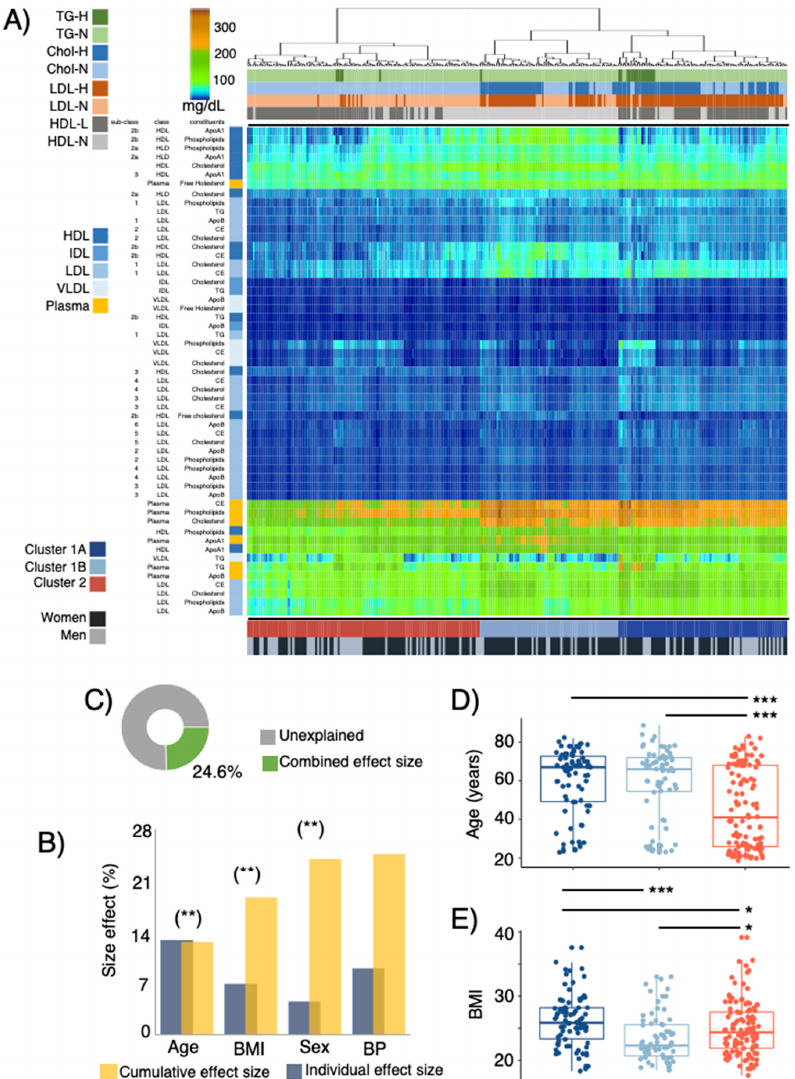
Figure 2. ( A ) Profiles of main and sub-fractions of plasma lipoprotein distribution (LPD) determined by 1 H-NMR [6]. LPD are clustered using Euclidean distances and general agglomerative hierarchical clustering procedure. Upper color bars represent within-/out- of the recommended levels of main lipoprotein fractions suggested by the NIH [41] (total cholesterol < 200 mg/dL, LDL < 100 mg/dL, HDL > 60 mg/dL, Triglycerides < 150 mg/dL). Lower color bars depict 3 clusters (C1A, C1B and C2) of study participants given their LPD profile and the sex distribution of subjects. ( B ) Cumulative effect size of non-redundant covariates of LPD determined by stepwise RDA analysis (right bars) as compared to individual effect sizes assuming independence (left bars). ( C ) Fraction of LPD variation explained with the stepwise approach. Distribution of ( D ) age and ( E ) body mass index (BMI) between subjects belonging to C1A, C1B and C2. Stars show statistical level of significance (* p ≤ 0.05, ** p ≤ 0.01, *** p ≤